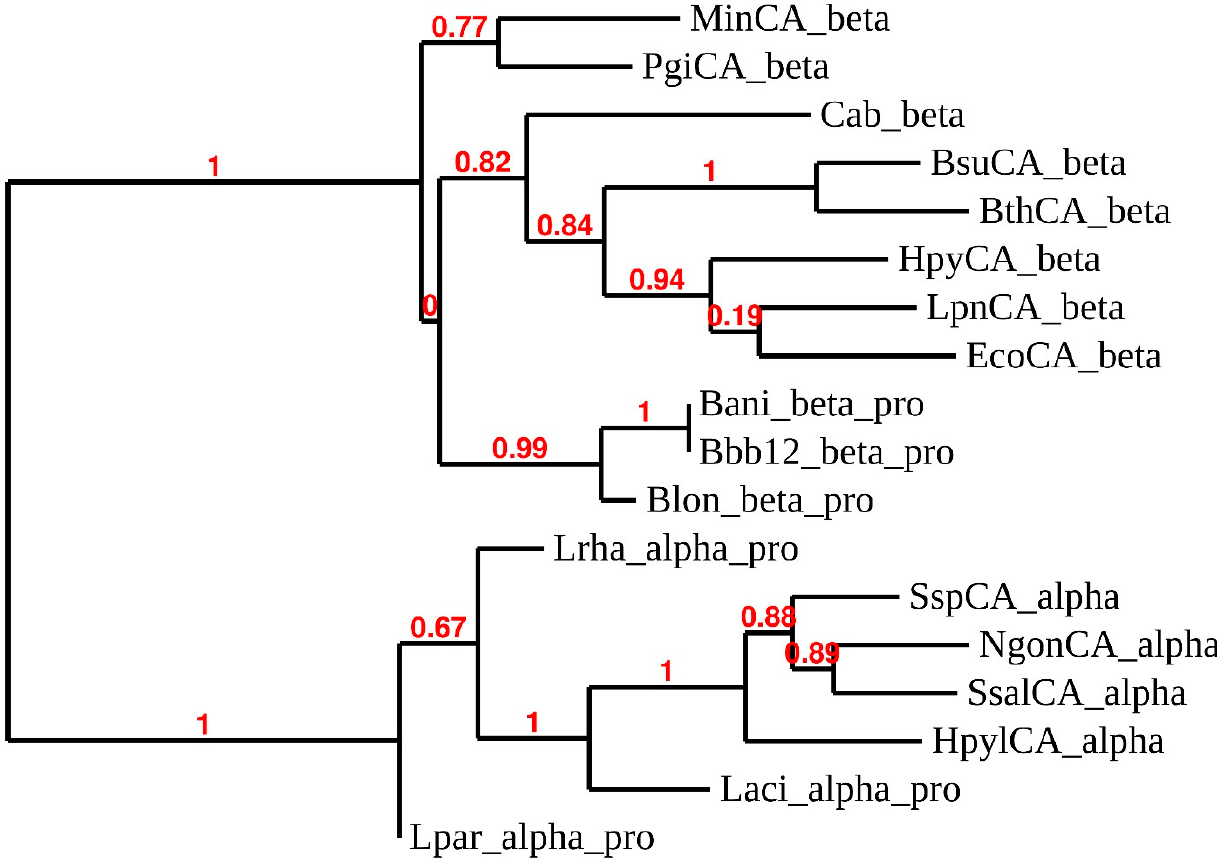
Figure 5. Phylogenetic analysis of CAs from various microorganisms. The dendrogram was obtained using amino acid sequences of probiotic strains in Table 4, and the α -CAs and β -CAs coming from multiple species of bacteria. Bootstrap values of 100 replicates are reported at branch points. Legend: see Table S2 for sequence accession numbers, CA-class, cryptonyms, and organisms considered.